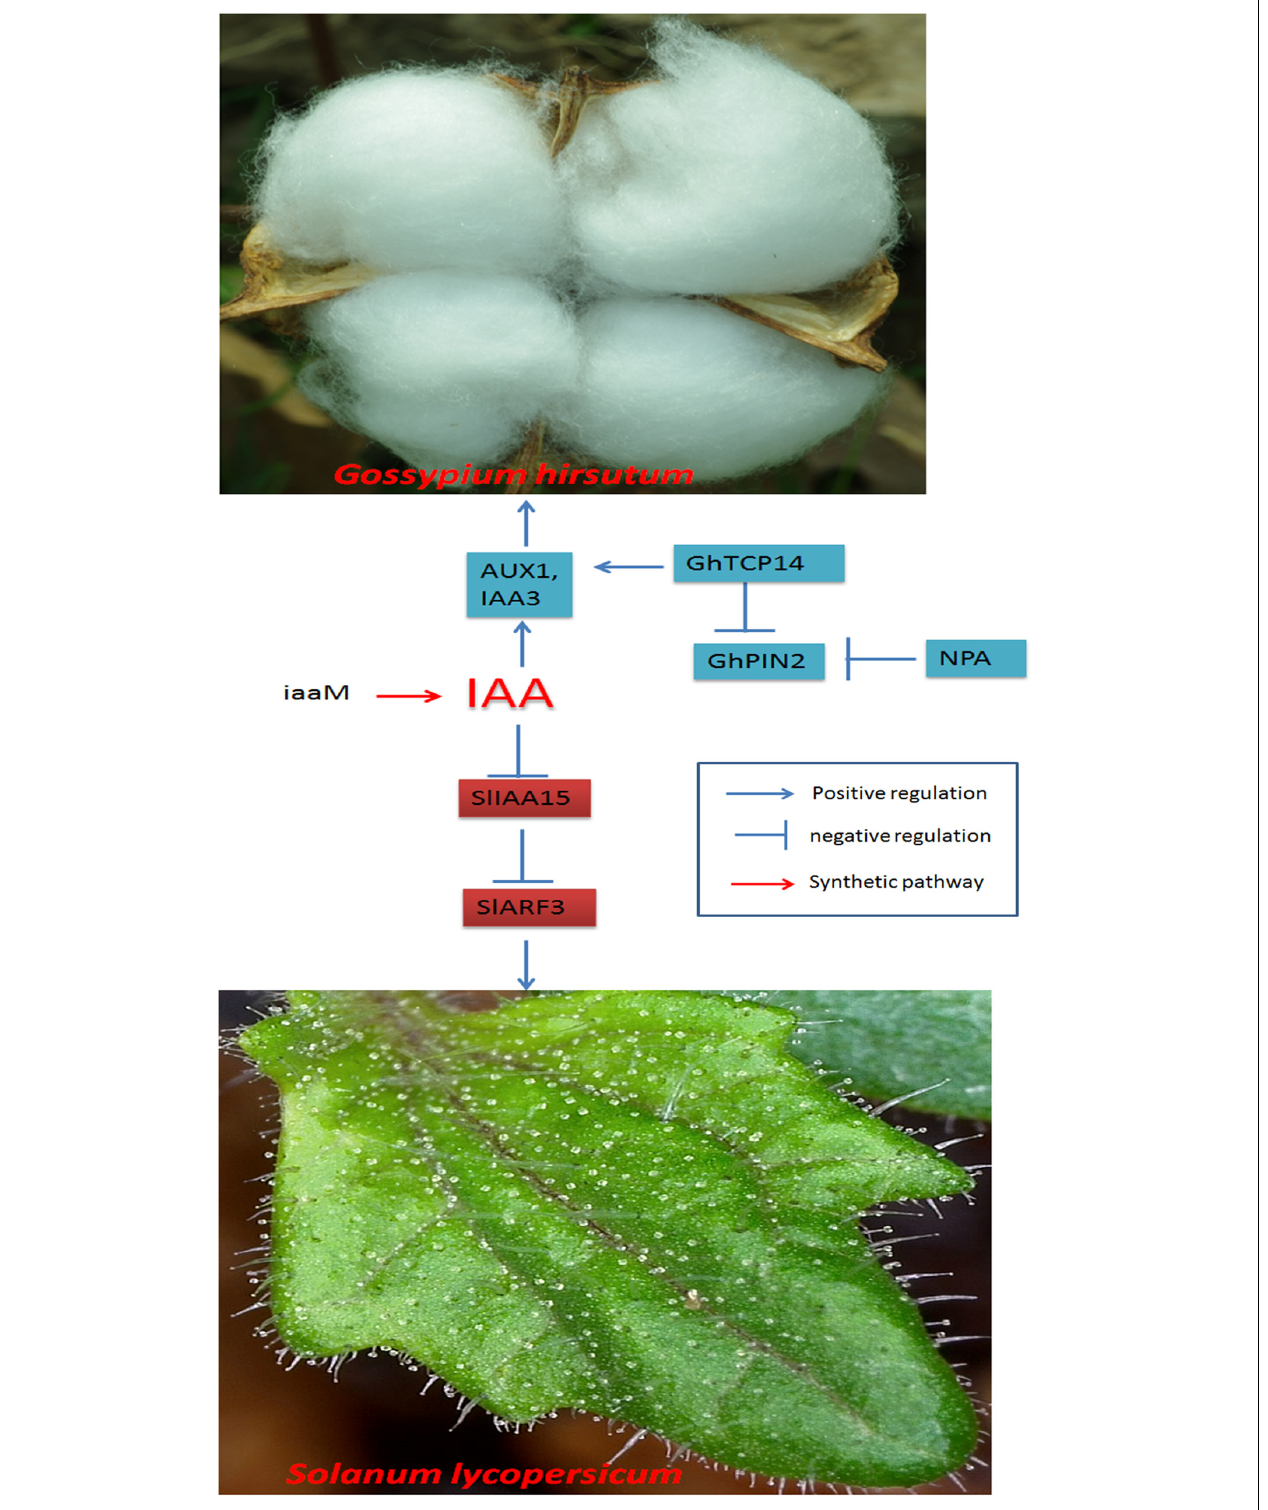
FIGURE 2 | Regulatory networks of cotton fiber and trichome development induced by auxin. NPA negatively regulates the expression of GhPIN2. GhPIN2 is a negative regulator of GhTCP14, and GhTCP14 directly modulates AUX1- or IAA3-promoted fiber initiation in cotton. SlIAA15 is an inhibitor of IAA signaling in tomato and is degraded when the auxin level increases, thus releasing ARFs and activating the transcriptional response.